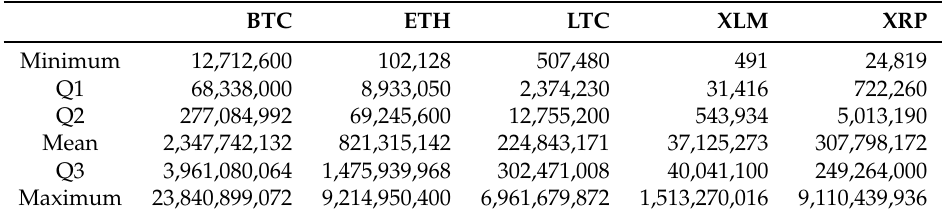
Table 5. Summary statistics of the volumes of the five cryptocurrencies. Daily trading volumes (in $)